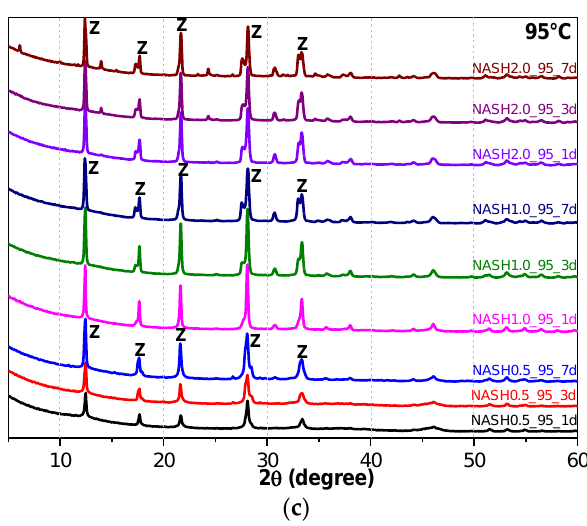
Figure 5. XRD patterns of N-A-S-H system product powders. ( a ) reaction at room temperature; ( b ) reaction at 60 °C; ( c ) reaction at 95 °C. (So: Sodalite; Fa: Faujasite; Z: Zeolite-P).